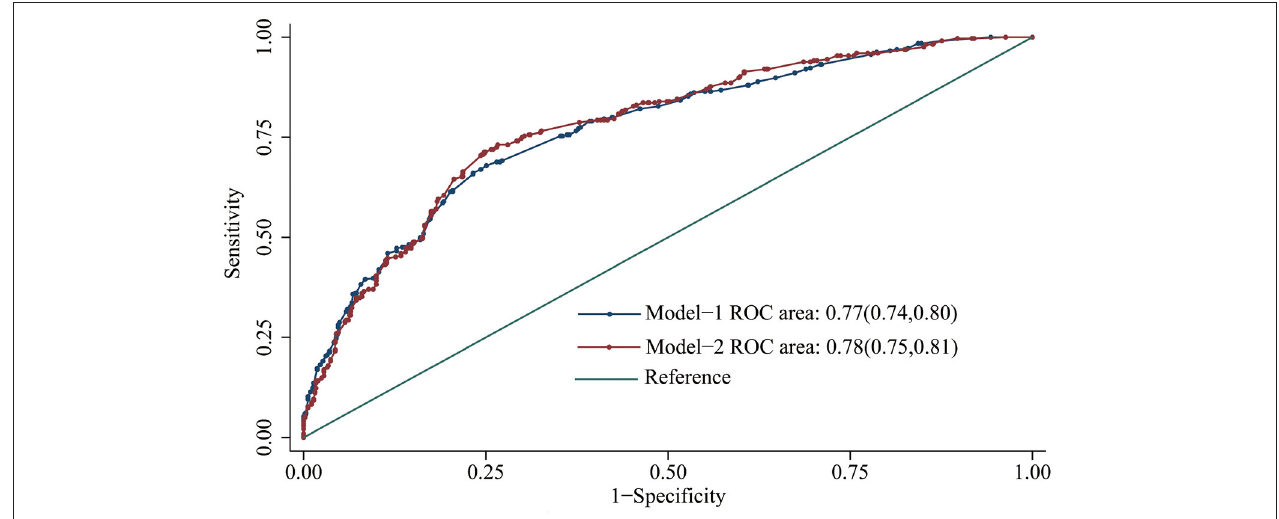
FIGURE 3 | Receiver operating characteristic curve of different multifactor models for predicting oral cancer